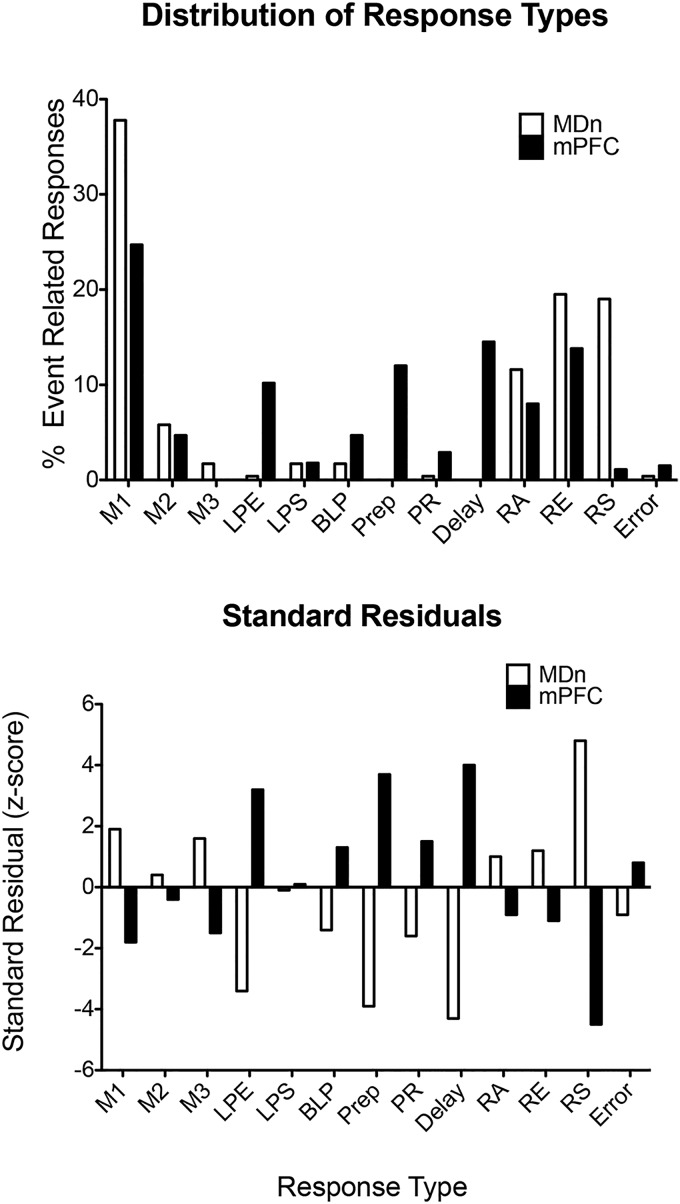
The upper figure shows the percentage of neurons that met criteria for movement 1 (M1), movement 2 (M2), lever press excitation (LPE), base lever press (BLP), delay-related (Delay), reinforcement anticipation (RA), reinforcement excitation (RE), and reinforcement suppression (RS), in MD (present study) and mPFC (data from Onos et al., 2016). These response types account for 231/254 (90.9%) criterion event-related responses in MD and 258/293 (88.1%) in mPFC. The lower figure shows standard residuals from χ2 analyses of these data plotted as z-scores. Positive residuals represent response types that were more frequent in one area than the other.